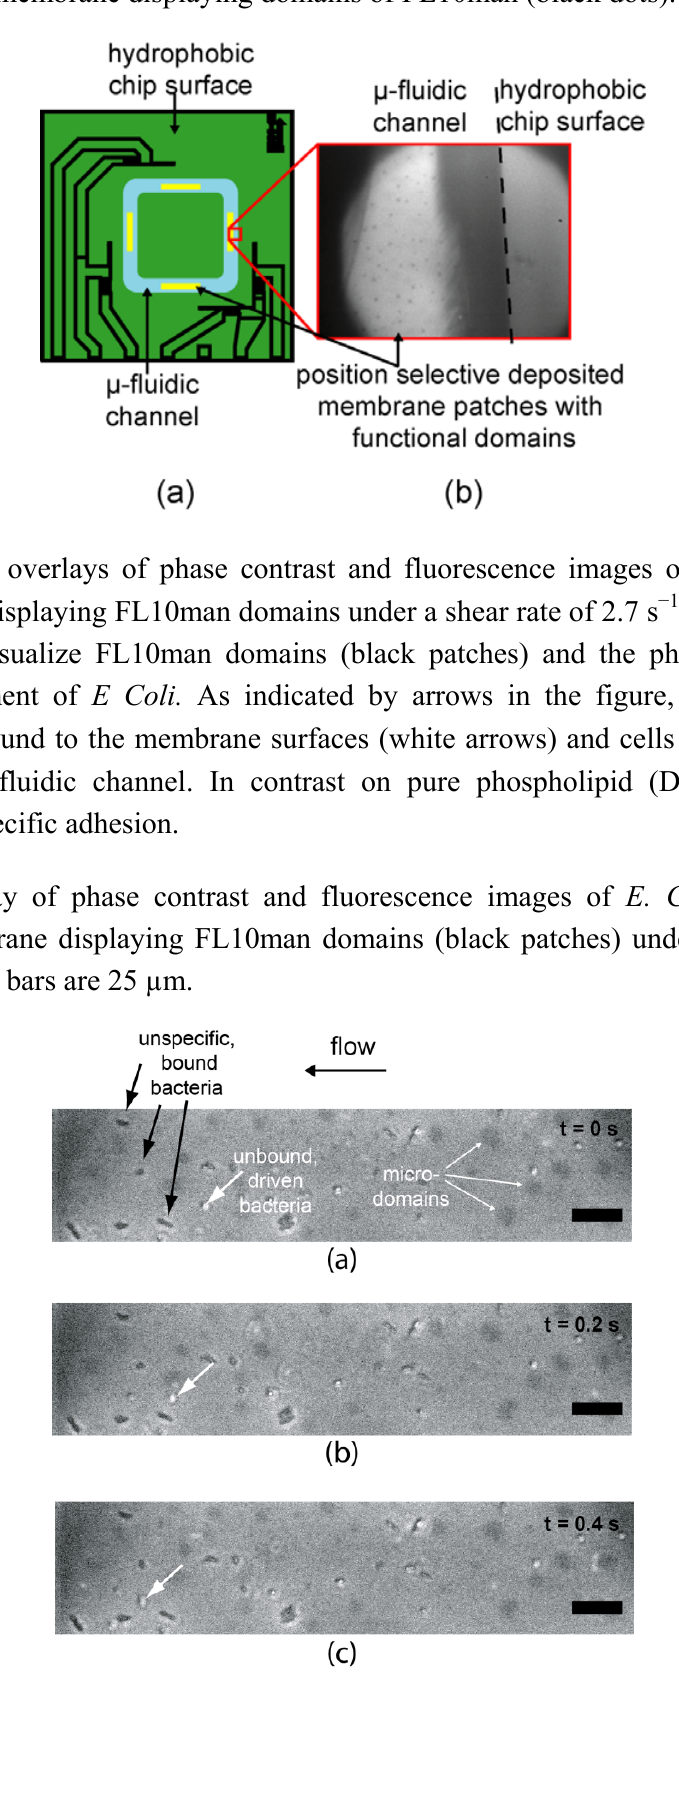
Figure 8. ( a ) Schematic illustration of the µ-fluidic chip layout. The regions highlighted in yellow are functionalized with asymmetric supported membranes; ( b ) fluorescence image of the supported membrane displaying domains of FL10man (black dots).